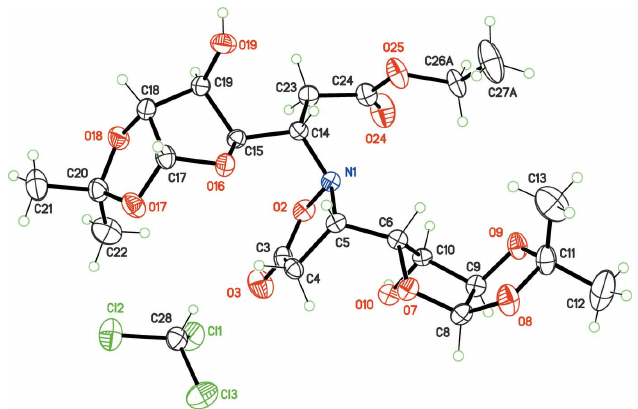
Figure 1 Structure of the title compound, with displacement ellipsoids for non-H atoms at the 30% probability level. For the disordered ethyl group in the ester functionality, only one disordered position is retained [ A site, with occupancy of 0.58